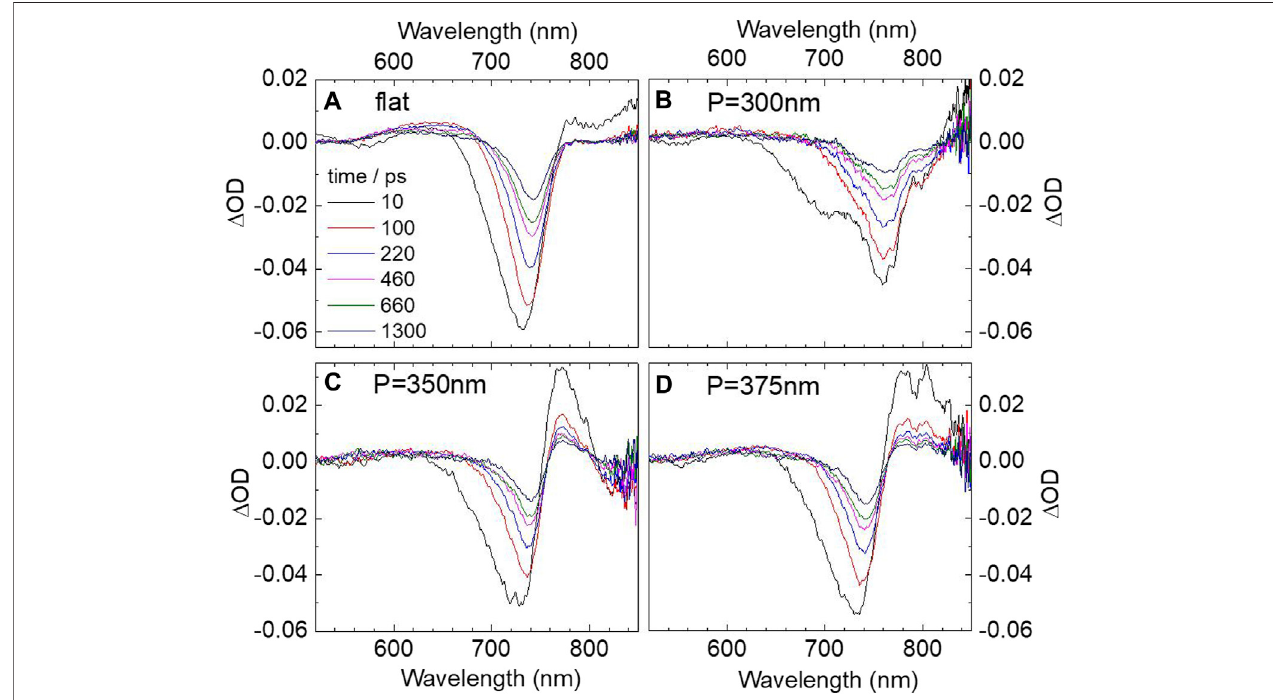
FIGURE 3 | Transient absorption spectra of CH 3 NH 3 PbCl x I 3-x perovskite fi lm on fl at (A) Al fi lm and (B – D) different Al nanopit arrays with periods of 300, 350, and 375 nm under 400 nm excitation. The spectra are recorded at 10, 100, 220, 460, 660, and 1300 ps.